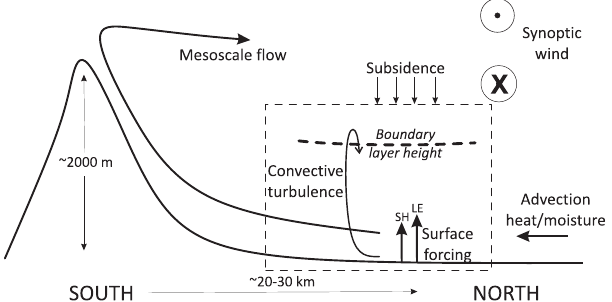
Figure 1. Sketch of the main process driving the development of the atmospheric boundary layer observed on 25 June 2011 (IOP5). The majority of the surface stations were located near the main site (see Fig. 4), whereas the aircraft measurements were gathered in an east–west direction during the case under study. Note that the shear produced by the opposite wind direction is occurring above the boundary layer ( ∼ 600m) as shown at Fig.